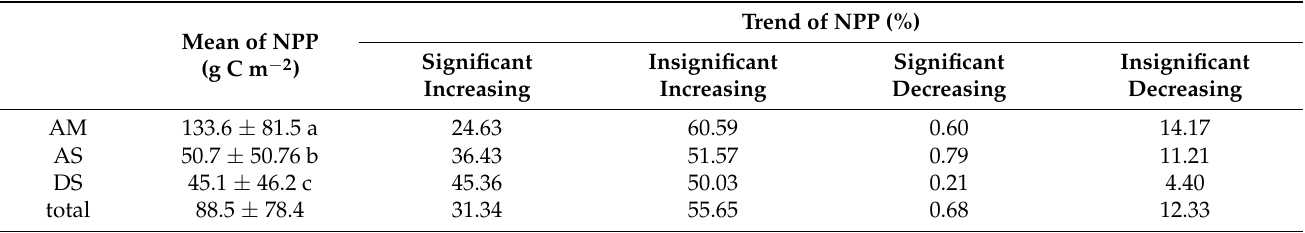
Figure 3. The spatiotemporal patterns of the grassland NPP on the QTP. ( a ) The mean of grassland NPP. The small map at the bottom shows the grassland NPP dynamics from 2000 to 2017. ( b ) The distribution of the trend in grassland NPP. The small map at the bottom shows the range of significance levels. Table 1. Percentages of grasslands with different variation trends in NPP across the whole plateau and within different grassland types from 2000 to 2017. AM, AS, and DS indicate alpine meadow, alpine steppe, and desert steppe, respectively. Different letters (a, b, c) denote significant differences between them ( p < 0.05).